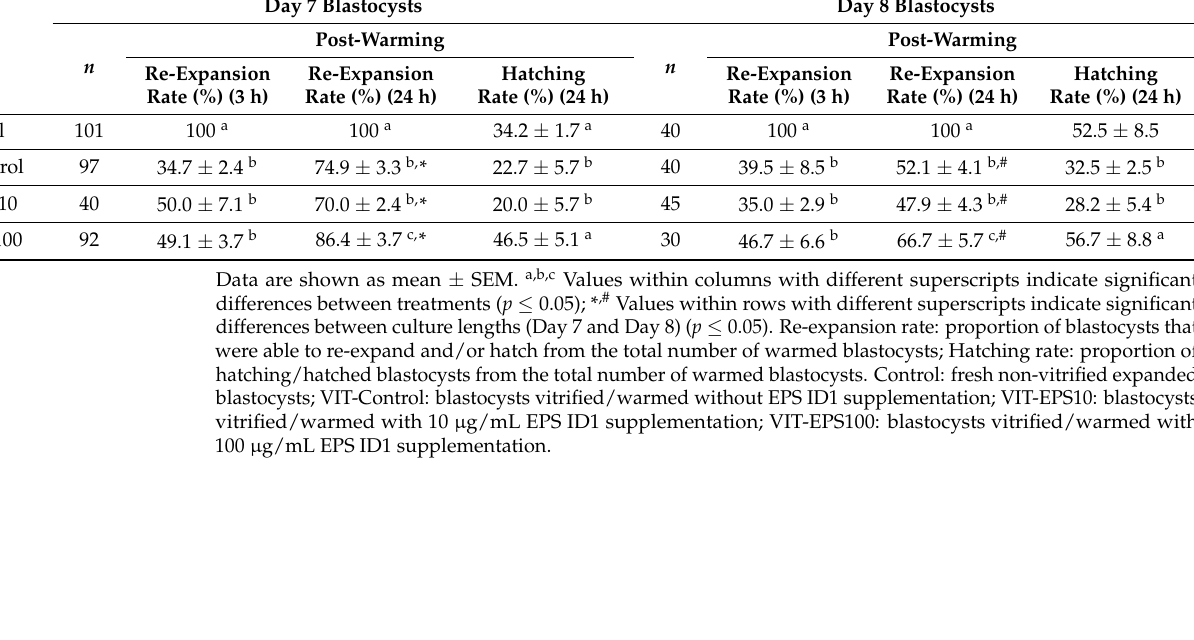
Table 1. Post-warming re-expansion and hatching rates of cow-derived D7 and D8 expanded blastocysts after vitrification with VIT-Control, VIT-EPS10, and VIT-EPS100. Blastocyst Derived from Cow